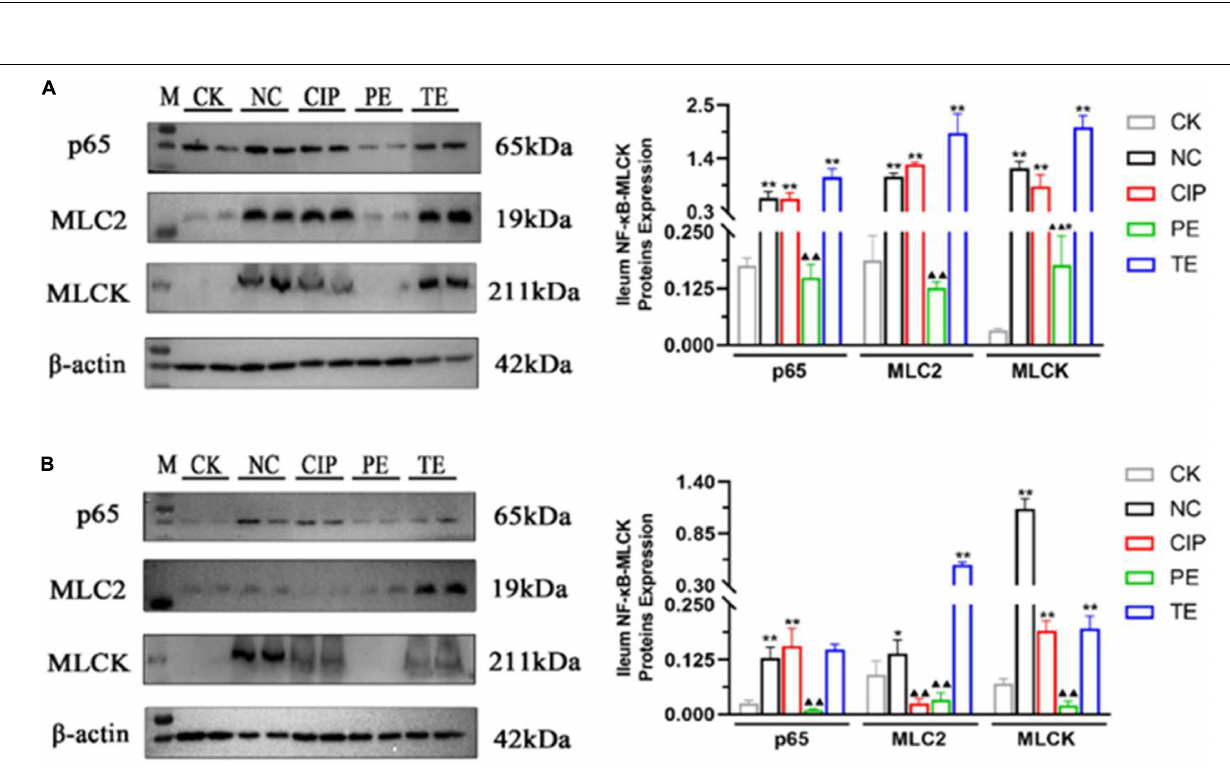
Frontiers in Nutrition |